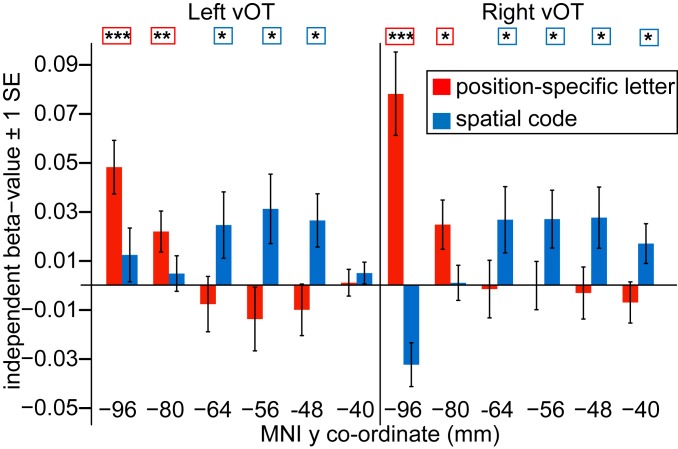
Results of a simultaneous multiple regression analysis examining the independent variance in the neural DSM accounted for by the position-specific letter and spatial coding DSMs. Left- and right-hemisphere ROIs go from posterior to anterior vOT along the x axis. Red and blue bars show the mean independent beta value for the position-specific letter and spatial coding DSMs. Asterisks denote whether second-level one-sample t tests on the resulting beta values for each predicted DSM in each ROI were significantly greater than zero (one-tailed t test, ***P < 0.001, **P < 0.01, *P < 0.05). SE bars are appropriate for these one-sample t tests.